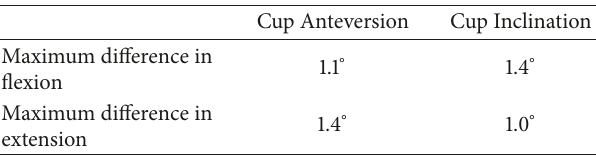
Table 1: Maximum difference in cup orientation, at impingement in flexion and impingement in extension, between the proposed impingement model and an independent CAD model.